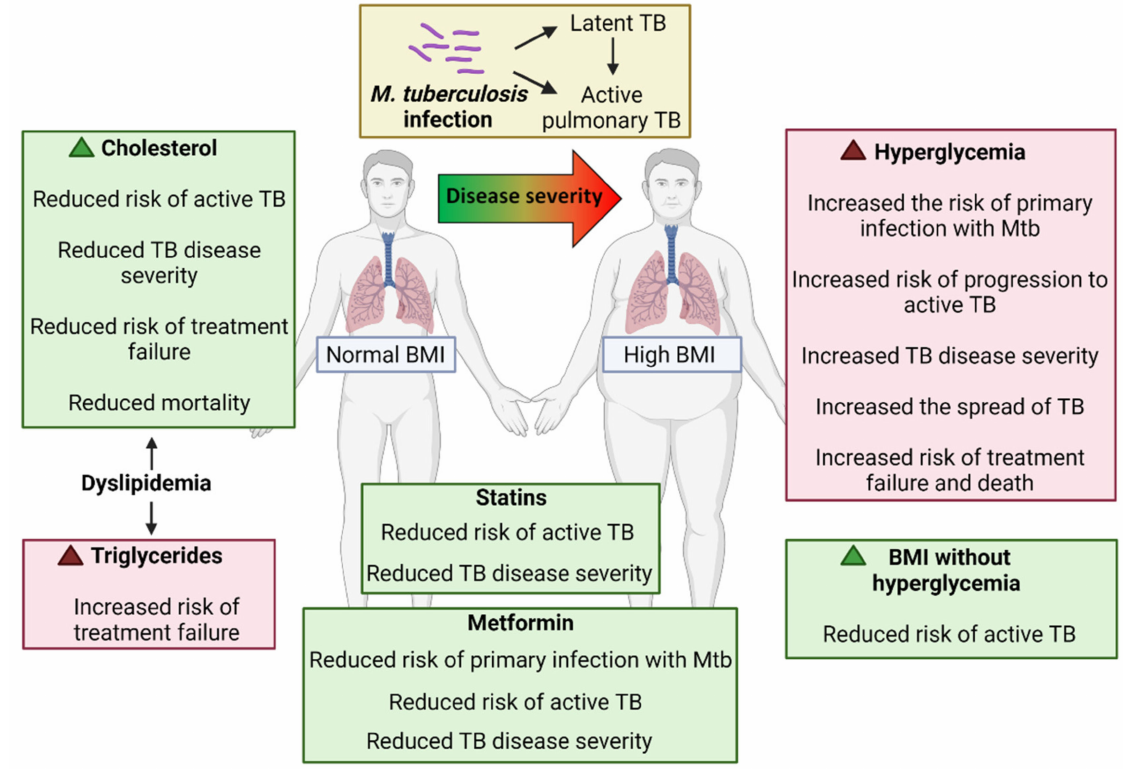
Figure 1. Schematic overview of the impact of cholesterol, triglycerides, hyperglycemia and BMI on risk of active TB, TB disease severity and treatment outcomes. Created with